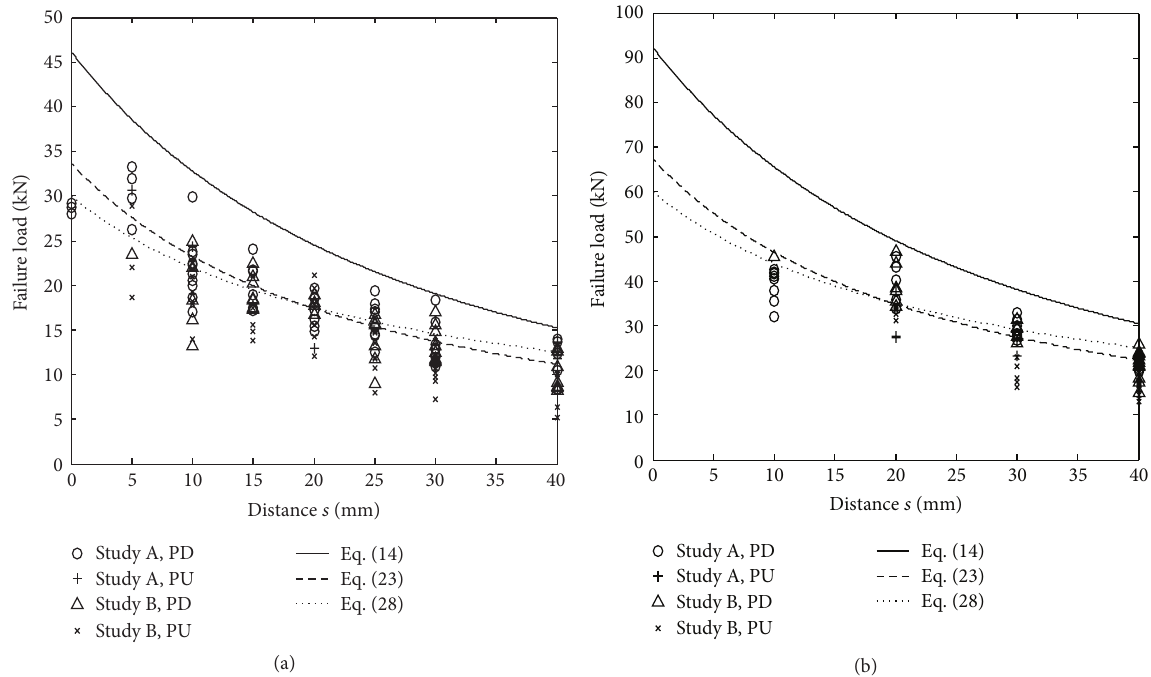
Figure 13: Comparison between theory and experiments for vertical cracking of a bottom rail assuming zero initial crack length. (a) Specimens with single-sided sheathing and (b) specimens with double-sided sheathing. PD = pith downwards, PU = pith upwards.